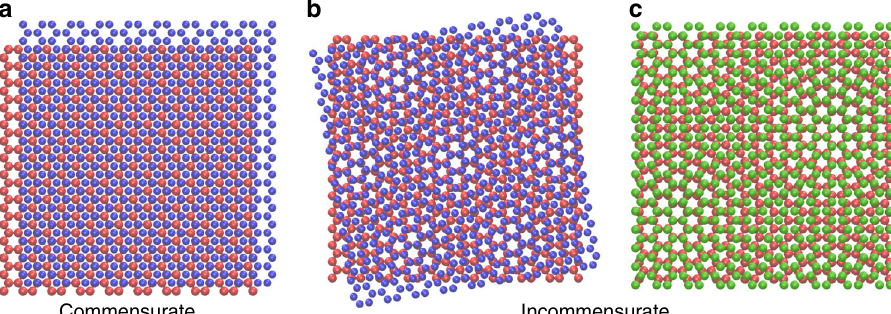
Fig. 2 Geometrical con fi gurations at crystalline interfaces. Mating identical surfaces with the same lattice spacing (red and blue) may give rise to both a commensurate interfaces when aligned and b incommensurate ones when orientationally misaligned at a mis fi t generic angle. c Structural incommensurability may also emerge when dealing with crystalline lattice-mismatched surfaces (red and green). The overall geometrical features of the contacting interface are captured in terms of the superstructure of the moire ’ interference